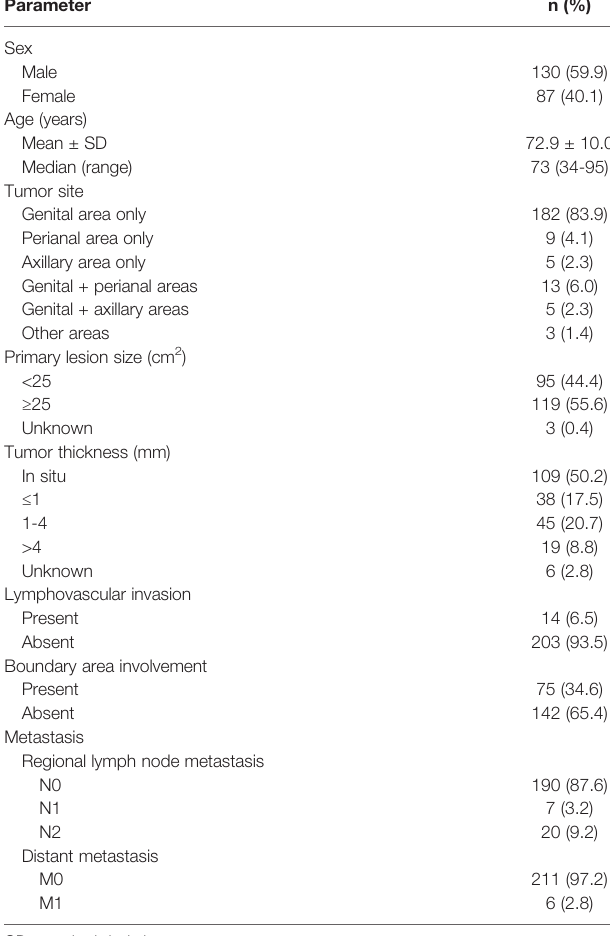
TABLE 1 | Demographics and clinical data of all 217